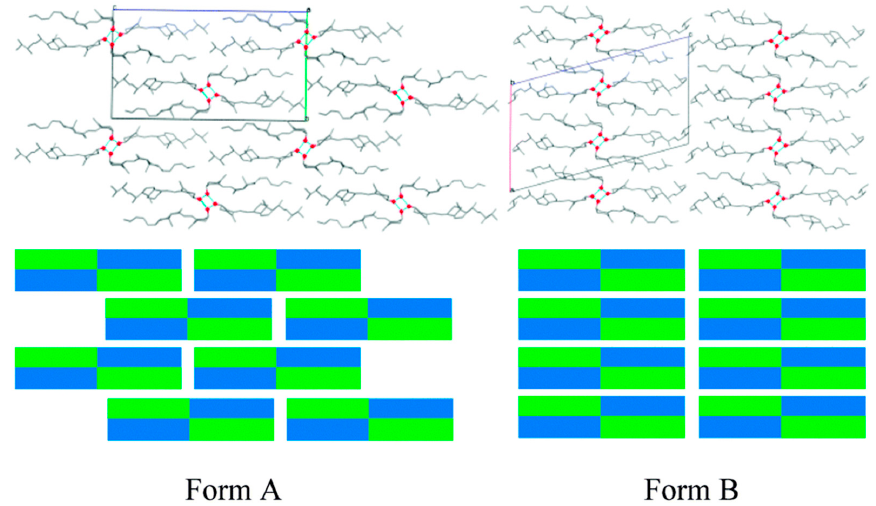
Figure 43. Packing arrangement of cocrystal form A and form B viewed along the helix structure.